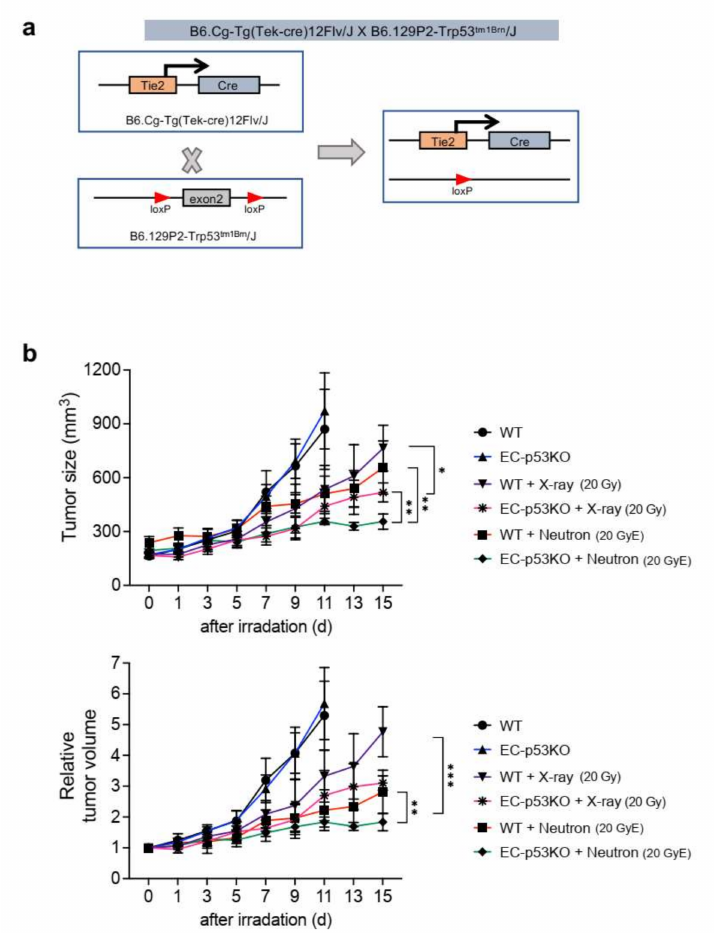
Figure 1. Endothelial-specific Trp53 deletion inhibits KP tumor regrowth after neutron irradiation or X-ray irradiation. ( a ) Schematic diagram of the endothelial-specific Trp53 exon2 deletion. Trp53 flox/flox (WT) and Tie2 -Cre; Trp53 flox/flox (EC-p53KO) mice were subcutaneously injected with KP cells in the right thigh. ( b ) Tumor growth in WT and EC-p53KO mice after no irradiation, X-ray irradiation (20 Gy), and neutron irradiation (20 GyE). Irradiation was performed when tumor tissues reached a volume of 150–200 mm 3 . Non-irradiated tumor tissues were obtained on days 0 and 11, and X-ray- or neutron-irradiated tumor tissues were obtained on day 15 after irradiation ( n = 6–7 animals per group). For ( b ), error bars indicate the standard deviation (SD); two-way analysis of variance (ANOVA) was used for multiple comparisons. * p < 0.05, ** p < 0.01, and *** p <